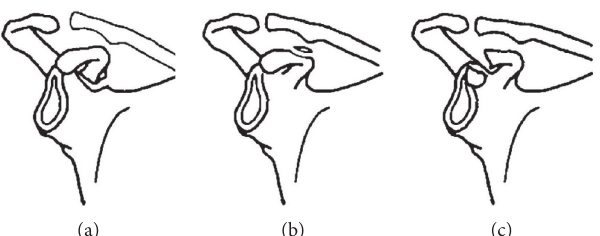
Figure 1: The proposed classification of epiphyseal separation of the coracoid process along with the anteroposterior radiograph and/or three-dimensional computed tomography reconstruction. Type I: the base including the area above the glenoid; Type II: the center with the coracoclavicular ligament; and Type III: the tip including the short head of the biceps and coracobrachialis, in addition to the pectoralis minor.